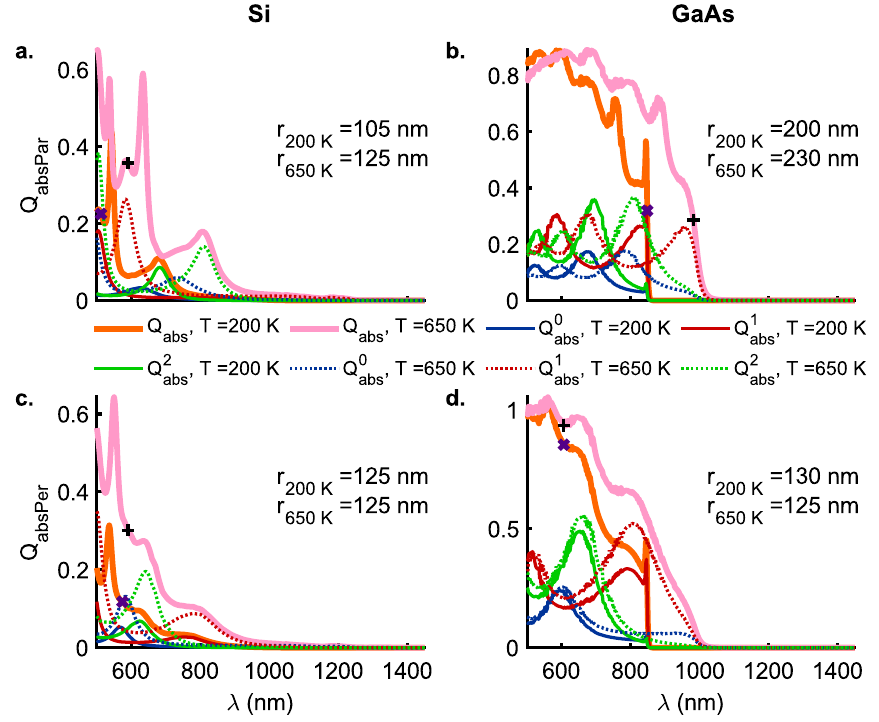
Figure 7. The absoprtion efficiencies Q abs for the TM ( E ) ( a ) Si, ( b ) GaAs, and, TE ( E ) polarizations ( c ) (cid:31) ⊥ Si and ( d ) GaAs with zeroth (blue), first (red) and second (green) order contributions as a function of the 200 (solid lines) and 650 (dotted lines) K . The thick orange and pink solid wavelength (cid:31) at temperatures T = 200 and 650 K , respectively. The radii lines represent the total absoprtion efficiencies, Q sca , at temperatures T = min of the nanowires considered here correspond to the global minima shown in Fig. 5 for Q sca as a function of the wavelength of the incident radiation. The purple ( ) and black ( ) markers correspond to the wavelength × + (cid:31) of the global minima in scattering efficiencies for nanowire radii ( r > 50 and 125 nm ) for TM and TE polarizations, respectively (see Fig. 5). Also, see Figs. S3 and S4 for a full color-map of the absoprtion efficiency Q abs for the TM and TE polarizations, respectively, of the incident radiation for Au, Si and GaAs nanowires as a 200 , 470 and 650 K function of the wavelength (cid:31) and radii r at temperatures T =